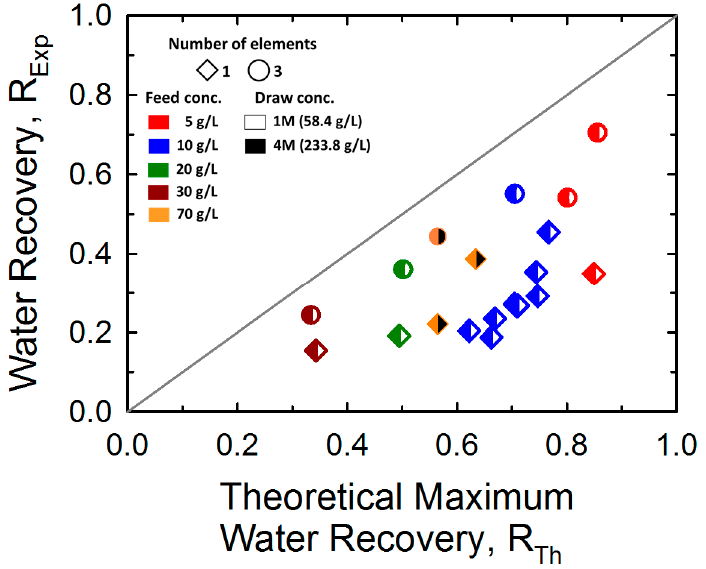
Figure 7 . Comparison between the experimentally obtained water recovery ( R Exp ) and the theoretical maximum water recovery ( R Th ). The applied feed (5, 10, and 15 LPM) and draw flow (5, 10, and 15 LPM) rates are not expressed individually for simplicity.